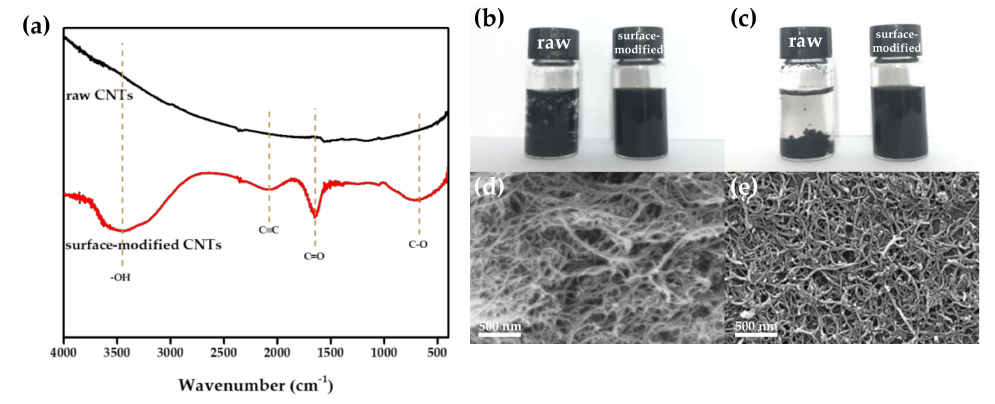
Figure 1. ( a ) FT-IR of the raw CNTs and the surface-modified CNTs; Dispersion state of the raw CNTs and the surface-modified CNTs in distilled water after standing for a certain time: ( b ) 0 h and ( c ) 24 h; ( d ) SEM image of the raw CNTs; ( e ) SEM image of the surface-modified